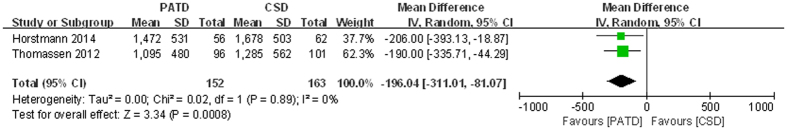
Forest plot and meta-analysis of total blood loss.